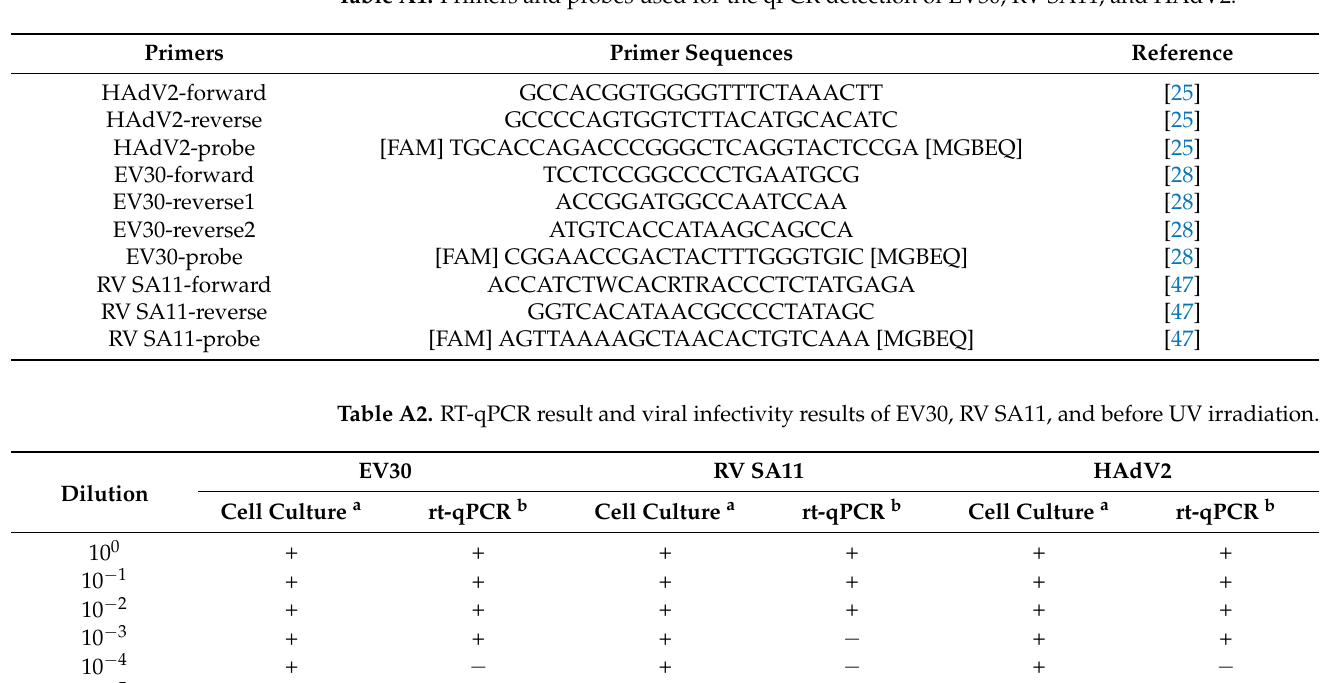
Table A1. Primers and probes used for the qPCR detection of EV30, RV SA11, and HAdV2.